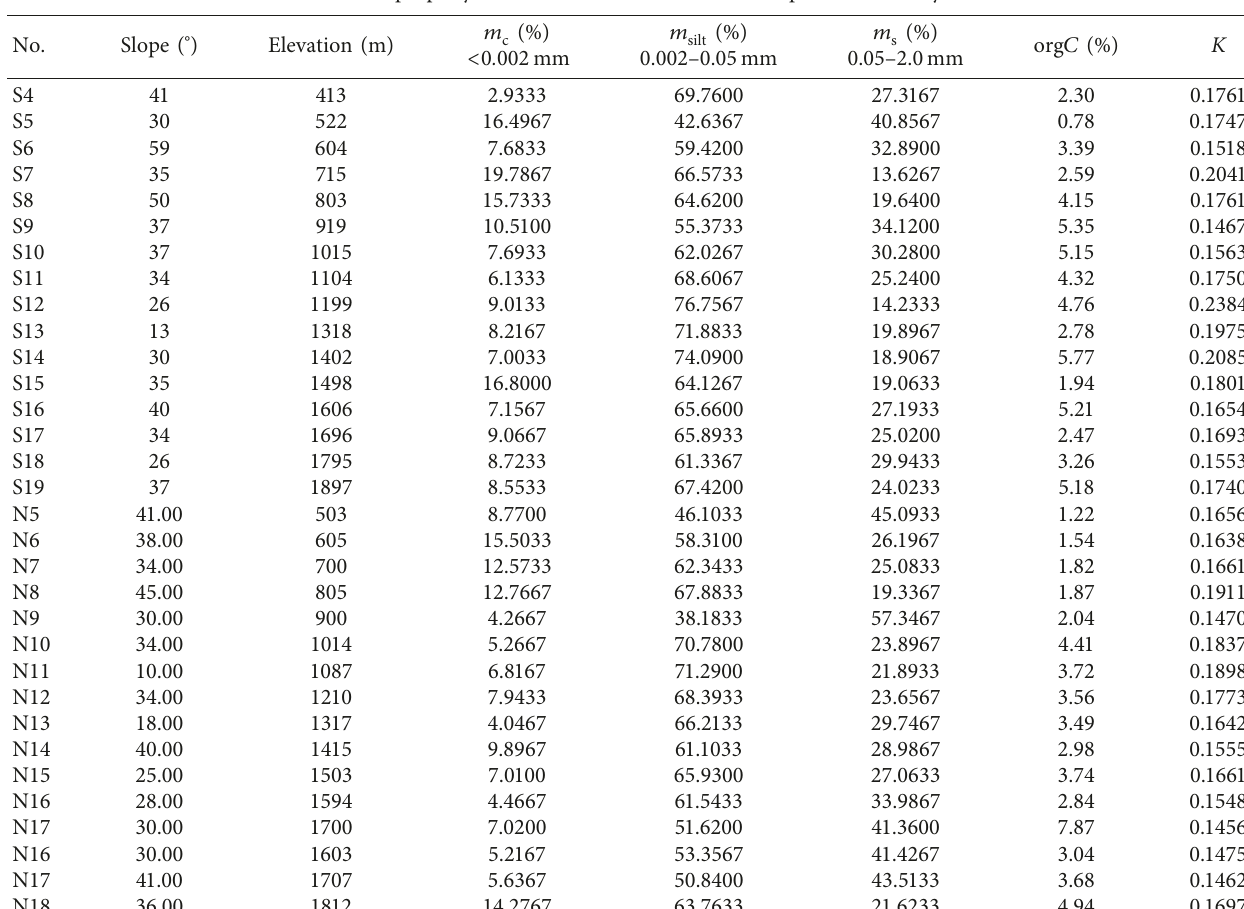
Table 2: The property and K -factors of 32 soil field samples in the study area.